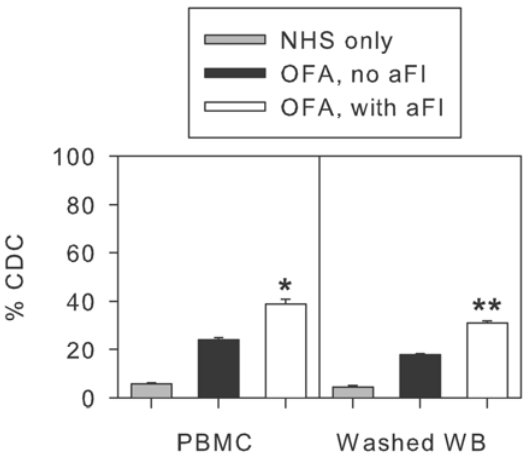
Figure 9. CDC mediated by OFA is increased in washed whole blood from a patient with CLL. CLL cells in 42% NHS or in washed whole blood were incubated with 7 µg/mL OFA in the presence or absence of 42 µg/mL mAb